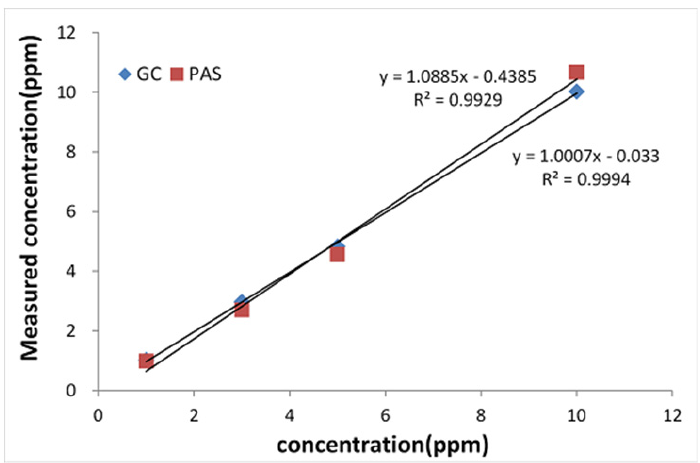
Figure 2. Calibration curve by GC and PAS.